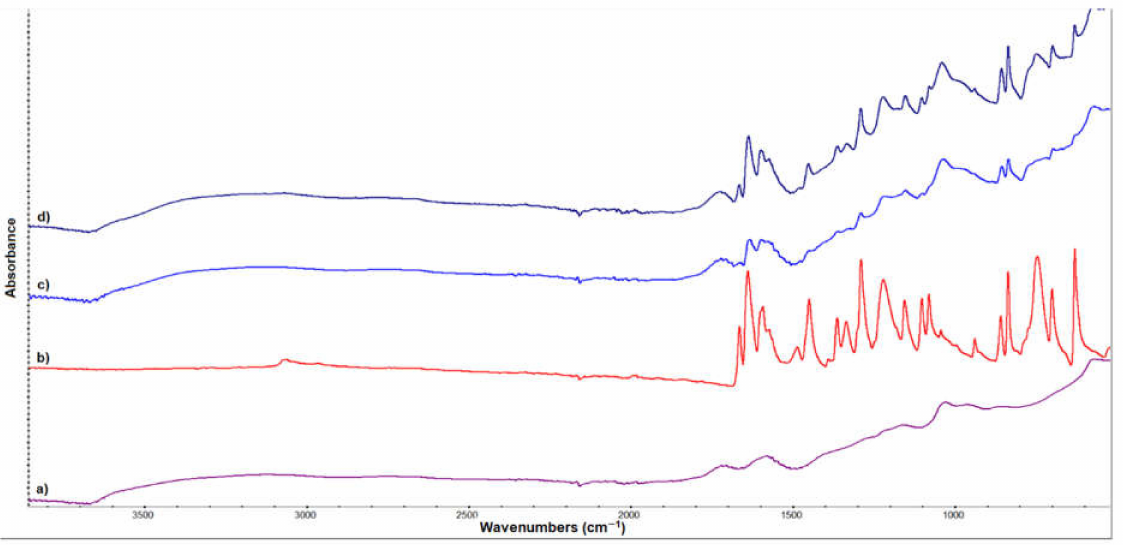
Figure 1. FTIR spectra for ( a ) GO, ( b ) Ju, ( c ) GOJu 5% ( w / v ) (juglone loaded onto GO nanocarrier), and ( d ) GOJu 10% ( w / v